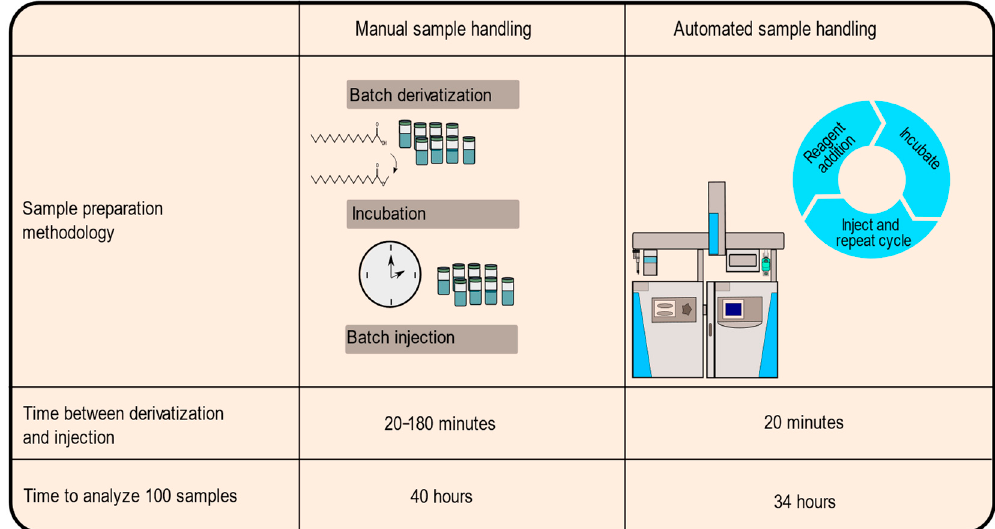
Figure 3. Reduction in time needed for analysis. Time-based comparison of manual and automated TMSH derivatization of fatty acids. Complete analysis of 100 samples manually in 10 batches of 10 samples each would require 40 h if batches were derivatized as soon as the previous batch finished. Automated derivatization would require 34 h with continuous derivatization and injection.